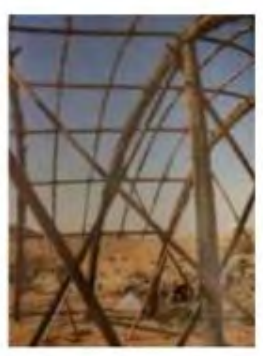
Figure 9. Rope based Connections (Piesik,